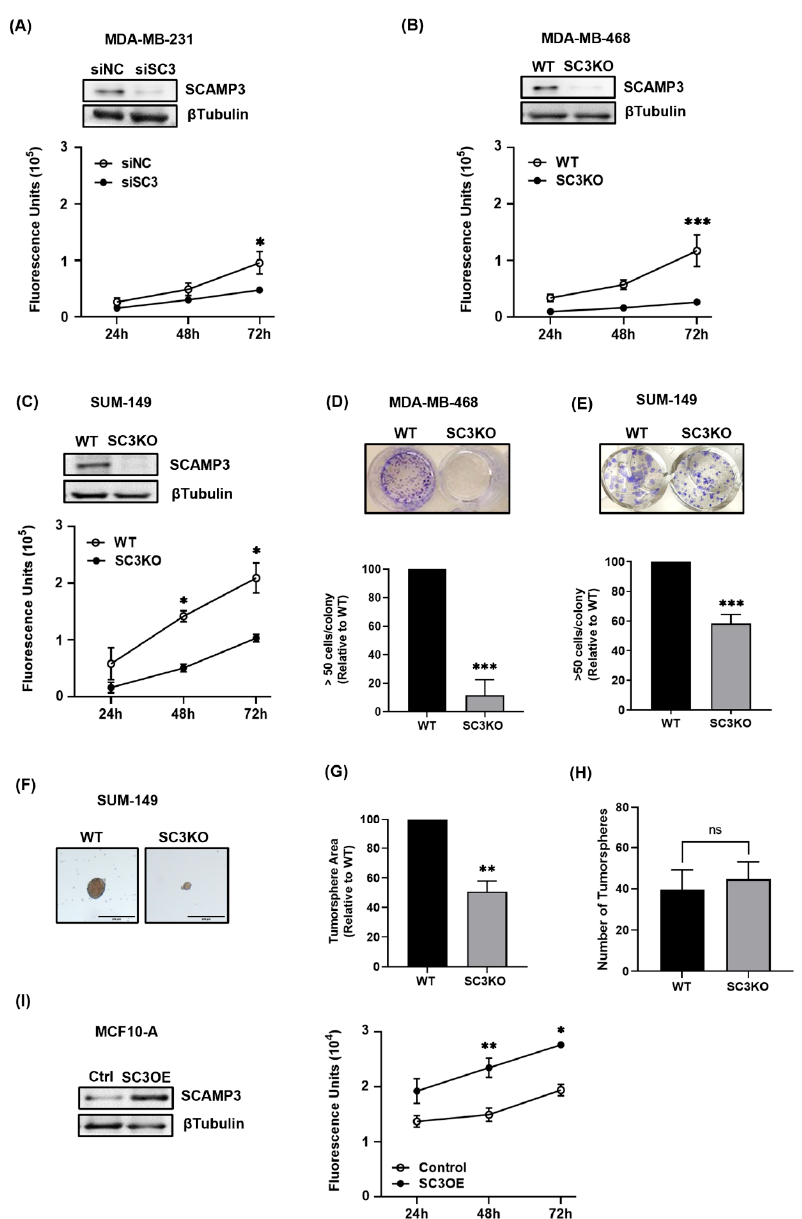
Figure 1. The proliferation of TNBC cells was suppressed after SCAMP3 knockout. ( A ) Immunoblot and proliferation of MDA ‐ MB ‐ 231 cells after transfected with SCAMP3 targeting siRNA (siSC3) and nontargeting sequences (siNC). ( B , C ) Immunoblotting and proliferation of wild ‐ type (WT) MDA ‐ MB ‐ 468 and SUM ‐ 149 cells after SCAMP3 gene knockout (SC3KO) using CRISPR/Cas9. WT and SC3KO ( D ) SUM ‐ 149 and ( E ) MDA ‐ MB ‐ 468 cells were incubated for ten days. The colonies were stained with crystal violet and the relative number of colonies with >50 cells was graphed. Student’s t ‐ test; *** p ≤ 0.001. WT and SC3KO SUM ‐ 149 were allowed to grow in a low ‐ attachment plate for three days to allow them to form tumorspheres. ( F ) Illustrated micrographs represent 5 photos per condition. ( G ) Area and ( H ) number of spheres were quantified using ImageJ. Scale bar = 200 μ m.